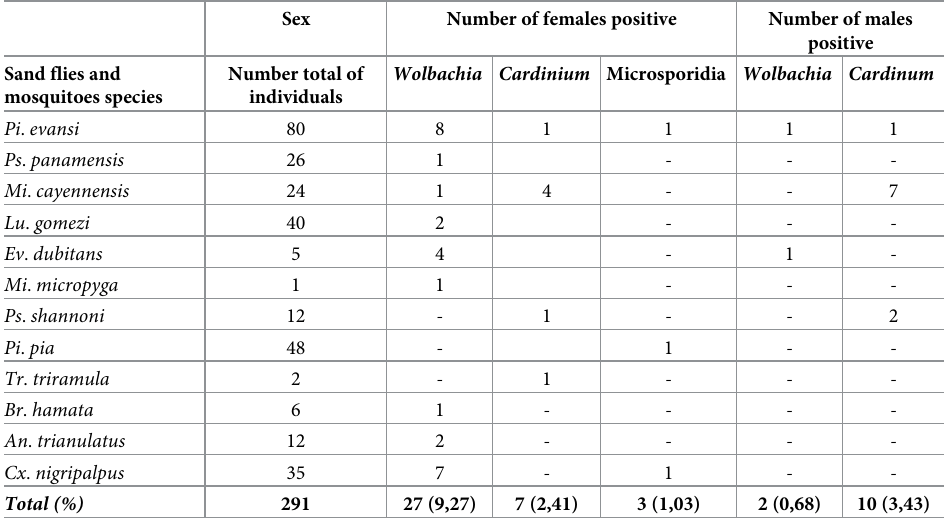
sequences. The global nucleotide alignment (580 bp) of the wsp gene included an additional 63 sequences from 59 arthropod-derived Wolbachia strains located in super groups A and B, as seen in the phylogenetic relationships of Bayesian inference (Fig 2). Clade posterior probability ranged from 0.8 to 1, indicating a robust analysis of Wolbachia phylogeny (Fig 2). Host wsp sequences were determined for Cx . nigripalpus , Br . hamata , and Lu . gomezi from Antioquia (Andean Eco-region), located in supergroup A, while the wsp sequences of phlebotomines ( Mi . micropyga and Ev . dubitans) from the Department of Cordoba (Eco-region Caribe) pres- ent a close relationship with strains of the "Leva" group located in supergroup B (Fig 2). Seven wsp sequences obtained from Cx . nigripalpus , with all similar nucleotide sequence suggesting a new strain named wCnig , forming a putative new group Cnig (Fig 2). Cnig’s spe- cific alignment (514 bp) suggests the presence of three haplotypes, 10 variant sites (S2 Fig), eight parsimoniously informative sites, and two singletons. Heterogeneity is distinguished at the beginning and end of the alignment (S2 Fig), indicating that K2P genetic distances ranged from 0.001 to 0.002 and the identity percentages between 98.33% and 100%. It was also deter- mined that Wolbachia wsp gene sequences were obtained from Lu . gomezi corresponds to a variant or haplotype of the wOri strain, while Br . hamata corresponds to a putative new strain named wBham, which is also related to the wOri and wCauB strains of Tosogodes and Ephete- sia , respectively (Fig 2). To confirm this result, 33 variable sites and three parsimoniously informative sites with a high number of singletons were determined in the specific alignment of this sequence grouping. The K2P genetic distances of wLgom with wOri and wCauB were 0.02, with wCnig 0.12 and 0.007 with wBham . The percentage of similarity of wLgom with wOri was 98.57%. In contrast, wBham presented distances with values of 0.17 with wCnig and 0.07 with wOri and wCauB . The percentage of similarity of wBham with wOri was 88.84%, as with wLgom , indicating a clear difference between these two strains. Wsp sequences of Mi . micropyga and Ev . dubitans were consistently located in the Leva group, as mentioned above, indicating that nucleotide alignment revealed the existence of 29 variant sites, eight parsimoniously informative sites, and heterogeneity was appreciated throughout the alignment (S2 Fig). The K2P genetic distance values ranged from 0.001 to 0.003, indicating that the Ev . dubitans are similar to the wLeva strain (identity percentages 99.28% − 98.8%), while the Mi . micropyga sequences are similar to the wLcy strain, where it